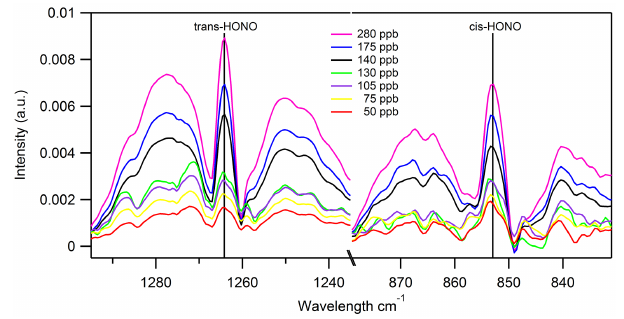
Figure 3. FT-IR spectra of dominant HONO absorbance lines at 1264 and 853cm − 1 over a range of concentrations.